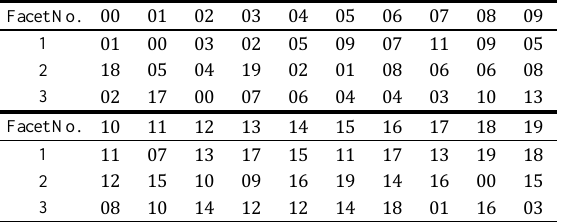
Table 6. 00 area was taken as the center for the icosahedron unfolding, the adjacent facet number in the three directions on arbitrary triangle